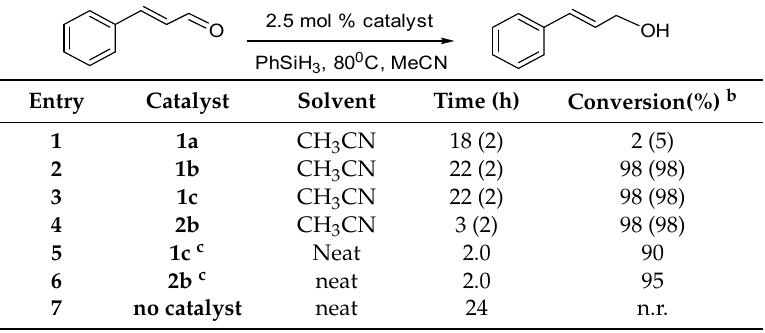
Table 1. Hydrosilylation of trans -cinnamaldehyde catalyzed by 1a–c , 2b a .